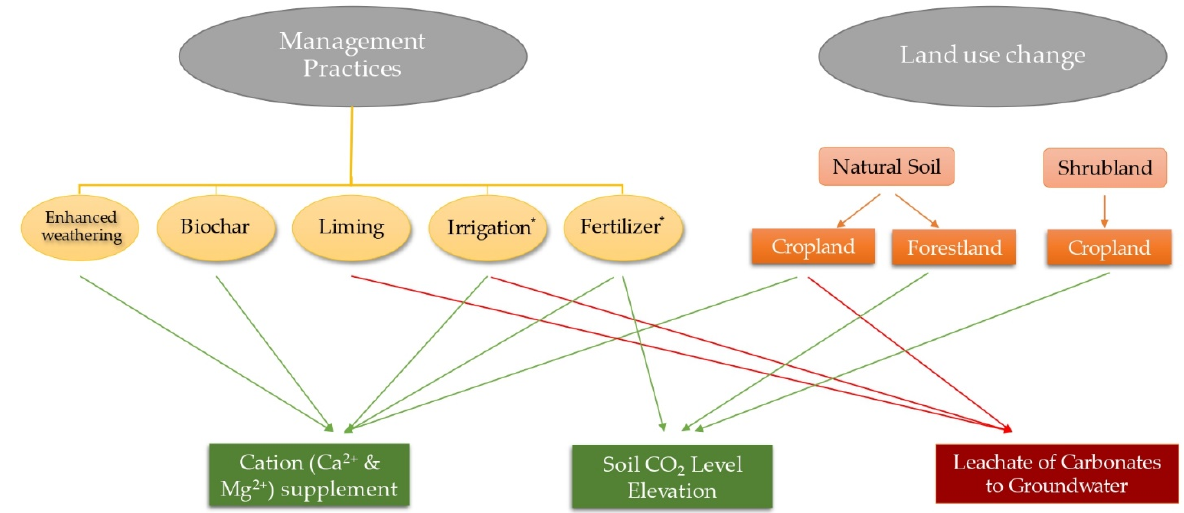
Figure 2. A summary of management practices and land-use change influencing the soil PC pool as documented in reviewed studies, highlighting how each activity might modify the carbonate pool (green: accumulation; red: dissolution and downward migration). * Depending on fertilizer/irrigation water and soil properties, different results were reported in reviewed studies. As this is an emerging field of research, note that a lack of arrow does not necessarily mean an influence is not possible; it just has not been reported to date.